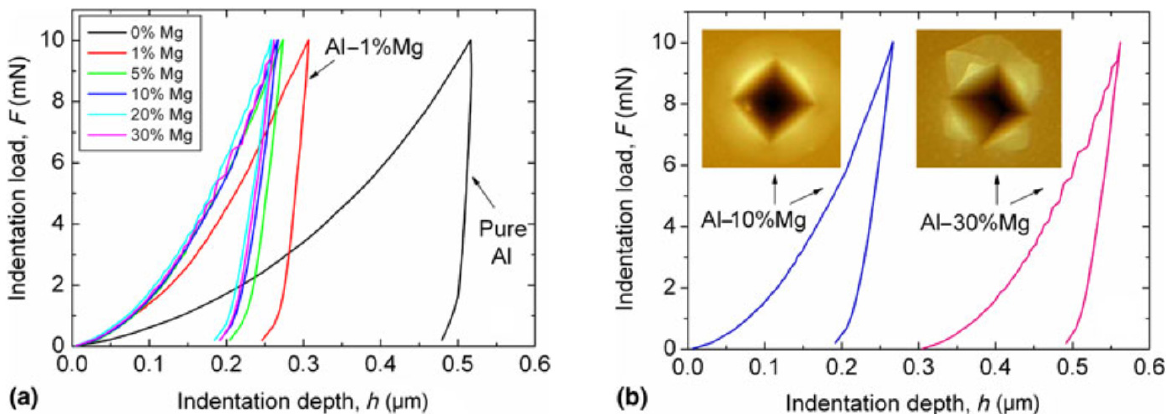
Figure 8. Indentation depth–load (h–F) curves of ( a ) the samples of various Al–Mg compositions and ( b ) of the Al–10%Mg and Al–30%Mg samples together with the corresponding AFM images regarding the indented surface (the h–F curve of the sample Al–30%Mg sample is shifted to the right by 0.5 μ m for clarity). Reproduced with permission from [31]. Copyright © 2019, The Materials Research Society.